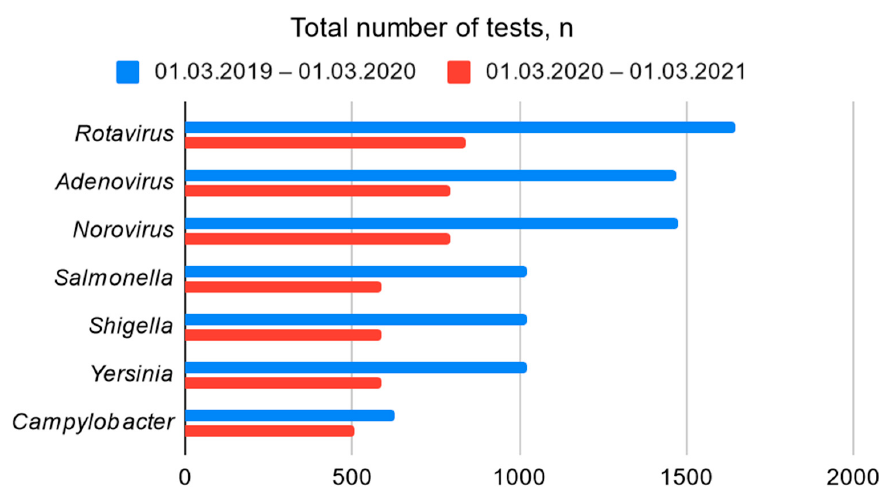
Figure 1. The total number of laboratory tests performed for EAOD and Infectious Diseases depart- ment’s patients.